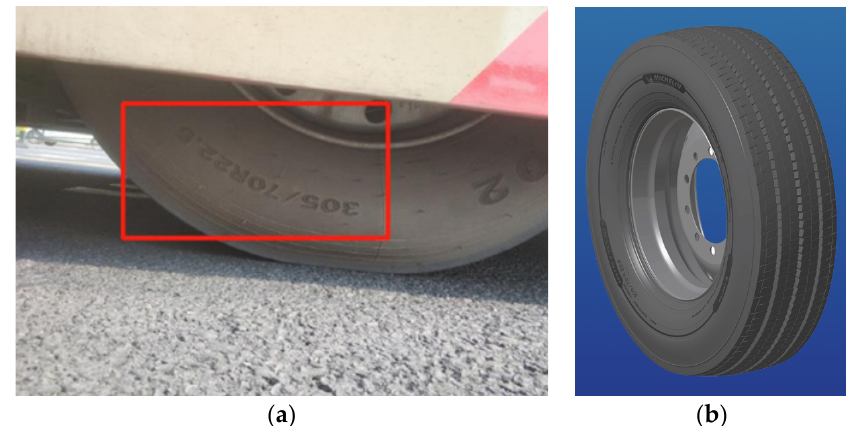
Figure 4. Tire used in ART system. ( a ) Field picture. ( b ) A 305/R70 22.5 tire.